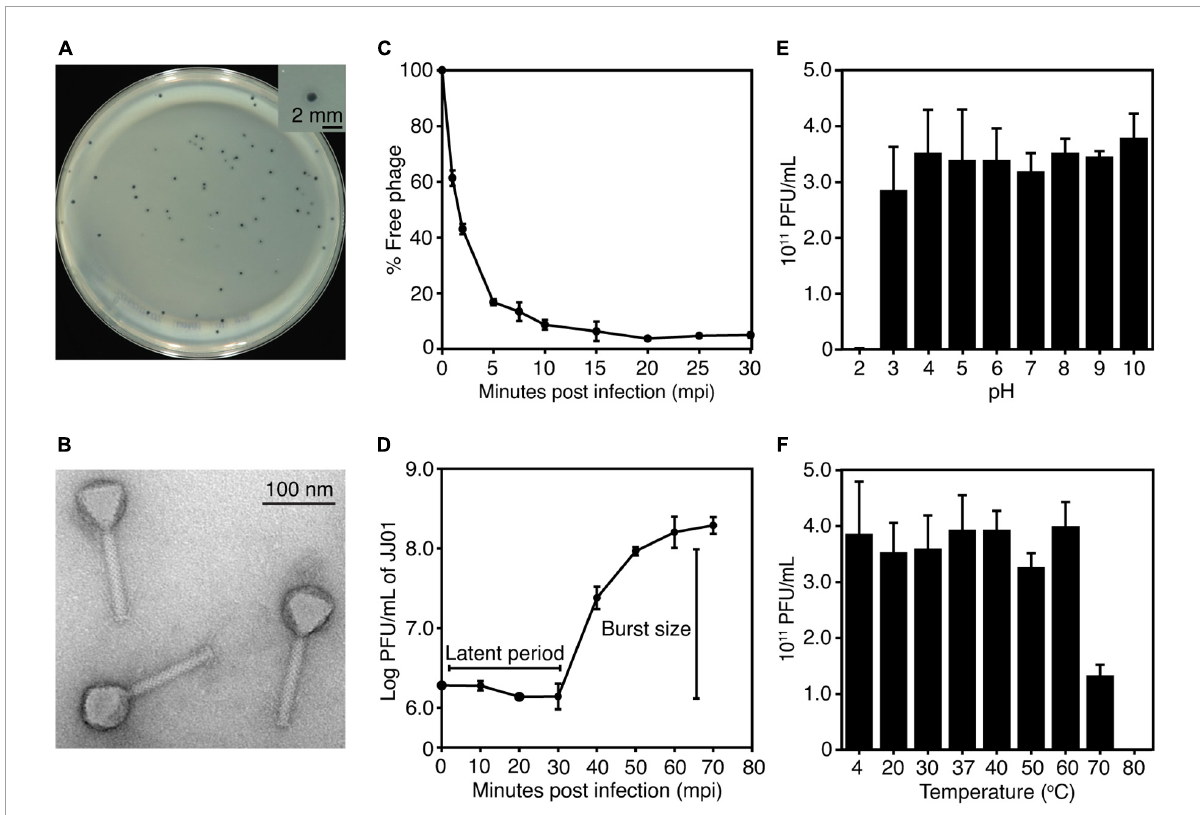
FIGURE1 (A) Plaque morphology of phage JJ01. The right panel shows an individual plaque of JJ01. Scale bar equals 2 mm. (B) A transmission electron microscopy (TEM) image of the purified phage JJ01. Scale bar equals to 100 nm. (C–F) Biological properties of phage JJ01. (C) Adsorption assay, (D) One-step growth curve, (E,F) pH and thermal stability. (C–F) Experiments were performed in at least three replicates and data were represented as the mean ± standard